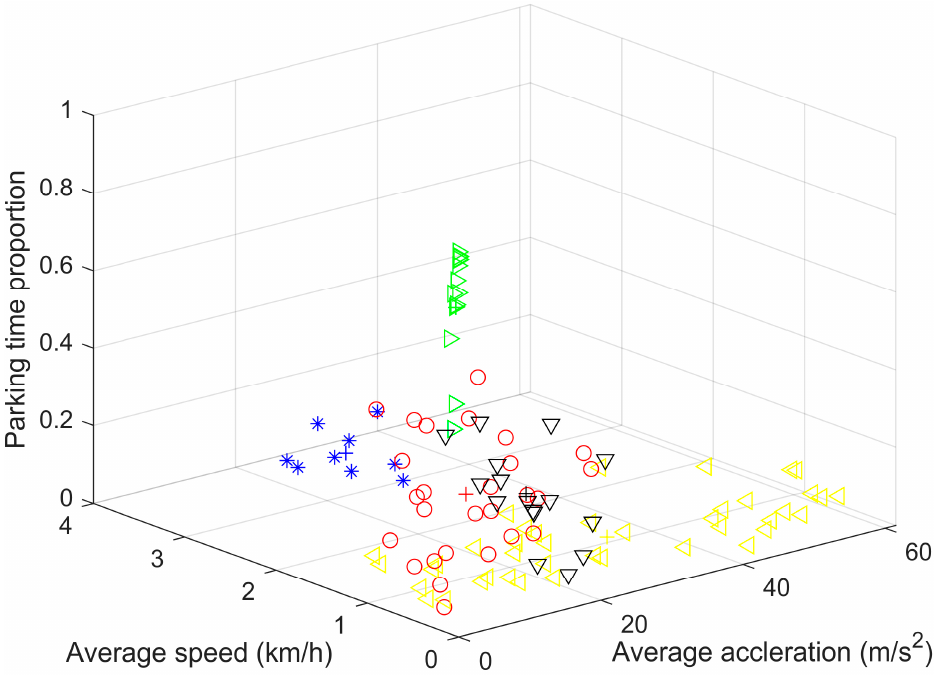
Figure 5. Classi fi cation results of the EM algorithm. Figure 5. Classification results of the EM